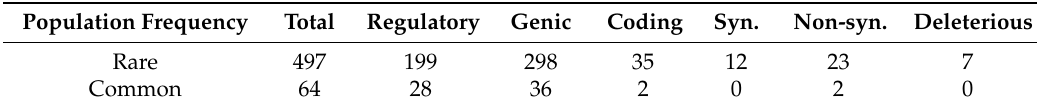
Table 2. Amount and location of rare and common SNPs within BAG1 (synonymous: syn; non-synonymous: non-syn). Population Frequency Total Regulatory